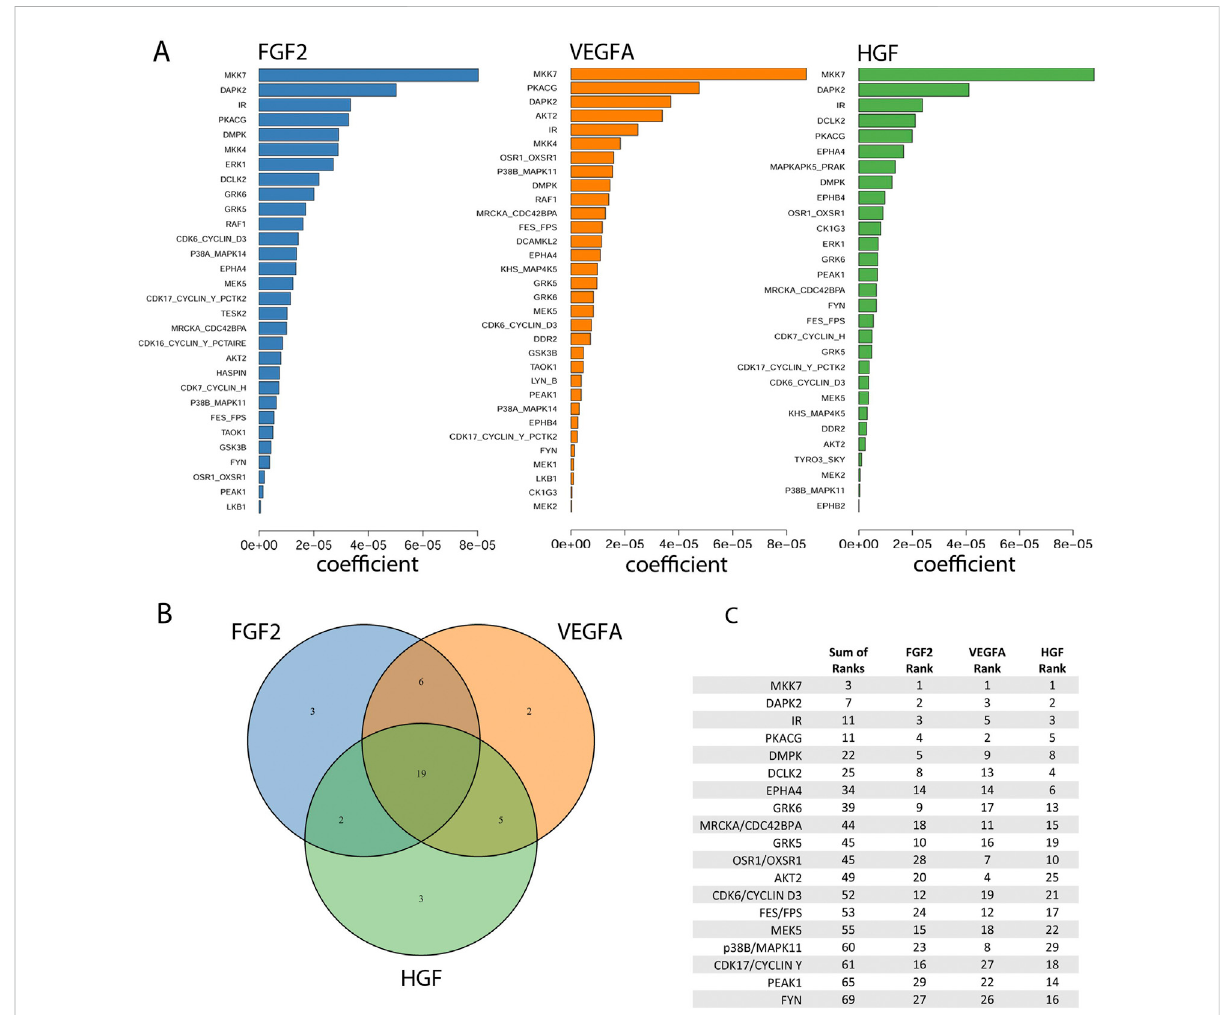
FIGURE 4 Identi fi cation of kinases important for the proliferation rate of Dermal Microvascular Endothelial Cells (DMECs) in each pro-angiogenic growth factor studied. (A) . Magnitudes of the Kinome Regression (KIR) coef fi cients (i.e., in fl uential kinases) for each identi fi ed growth factor. (B) . Venn diagram revealing the exclusivity and commonalities in the set of kinases identi fi ed for each growth factor. (C) . The list of the intersection of kinases implicated in all three growth factors. Kinases are ordered according to a rank obtained by summing each kinase ’ s ranks across all growth